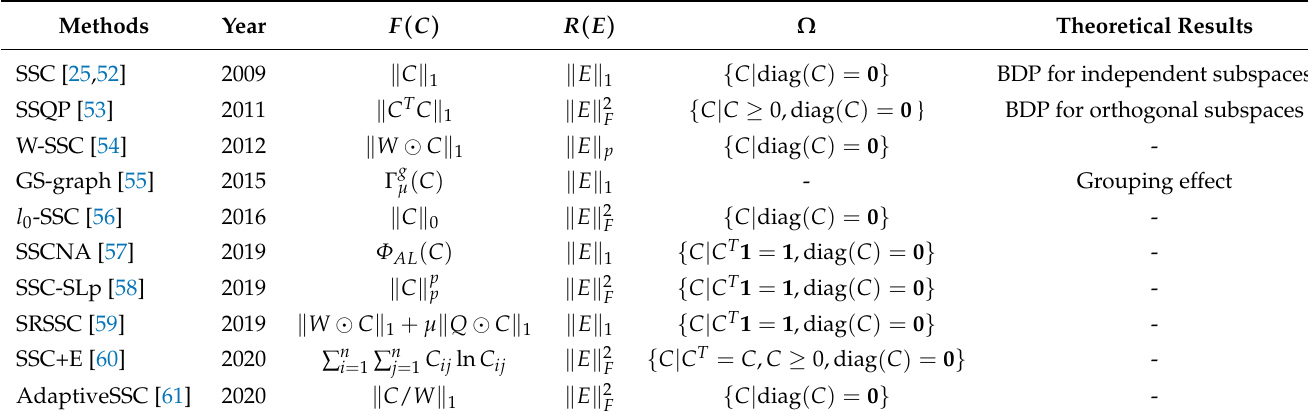
Table 2. The comparison of classical sparse SC